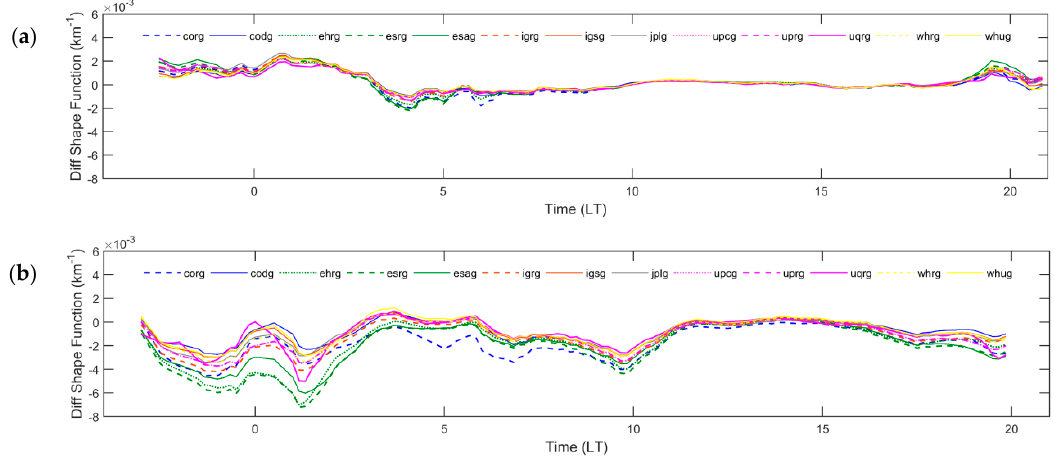
Figure 7. Differences between slab thickness are estimated for the ionosonde positions of two pairs of ionosondes: ( a ) FZA0M and SAA0K, the closest one; and ( b ) CAJ2M and BVJ03, the most distant one.